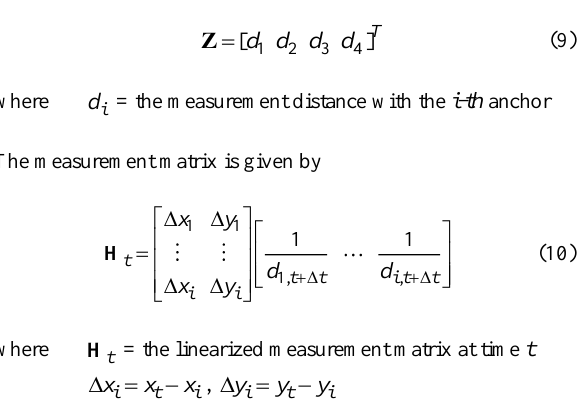
Figure 4. Electro-rotating actuator with programmable speed for evaluating the rapid movement detection. The test lasted about 20 s. The number of the valid samples points is about 5086 based on the statistics measurement results.